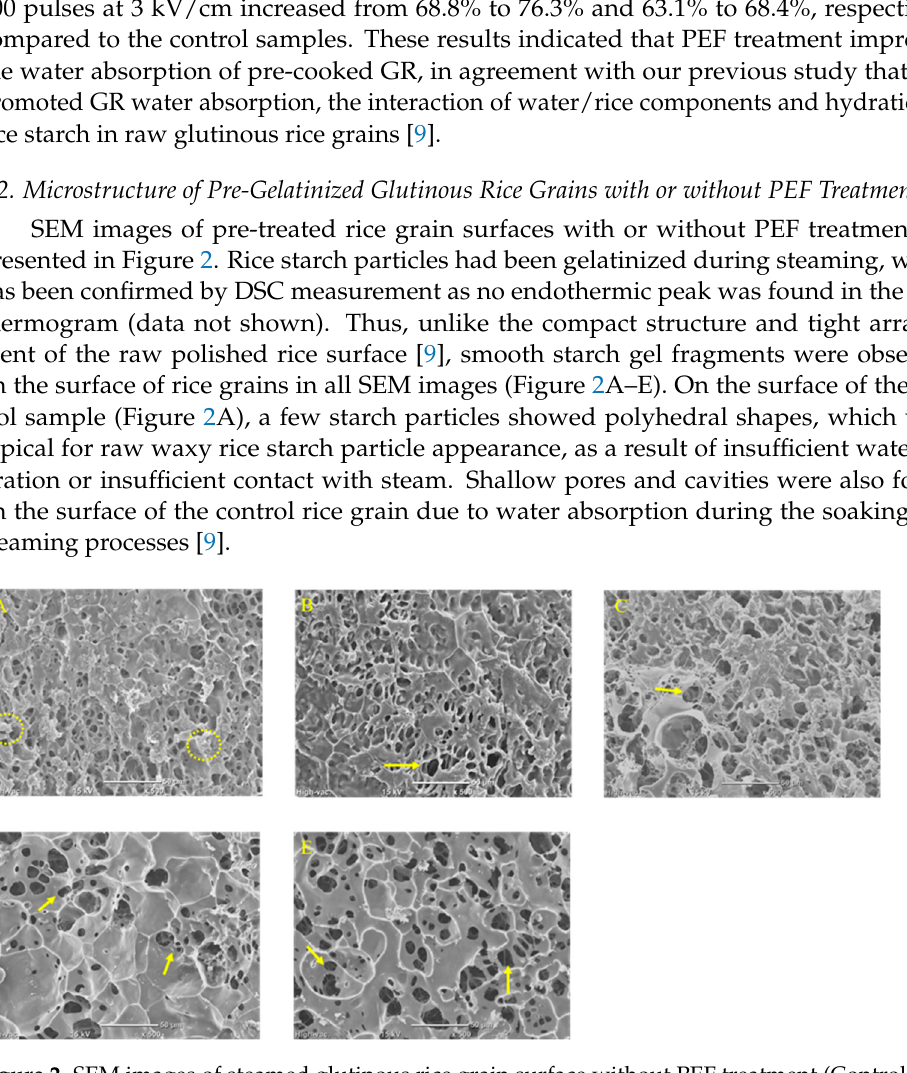
Figure 2. SEM images of steamed glutinous rice grain surface without PEF treatment (Control, ( A )), and with 100 ( B ), 200 ( C ), 300 ( D ), and 400 ( E ) pulses of PEF treatment. Insufficient gelatinized starch particles were circled ( A ). Arrows indicate the pores or cavities on the PEF-treated rice grain surface. The SEM images captured for all samples provided a 500× magnification and used the scale bar of 50 μ m.